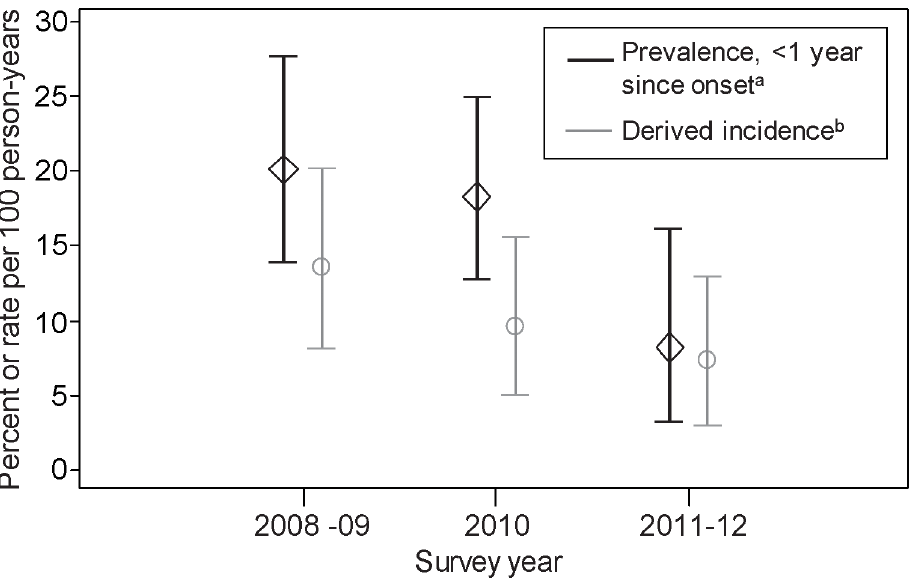
Figure 2. Prevalence (among recent onset injectors) and derived incidence of HCV among people who inject drugs in Scotland, 2008 to 2012. The diamonds/circles represent the point estimate and the bars represent the upper and lower 95% confidence intervals. a anti-HCV prevalence among those who commenced injecting within the past 12 months. b Determined by applying the estimated pre-seroconversion window period to the observed number of anti-HCV negative and HCV-RNA positive individuals (see methods for details). Restricted to those who had injected in the last 6 months.